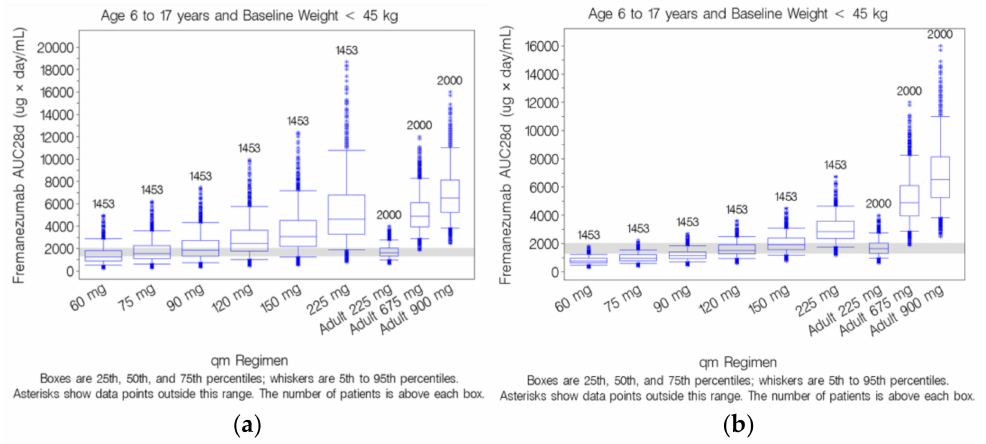
Figure 3. Simulated steady state fremanezumab AUC 28d for pediatric patients 6 to 17 years of age with baseline body weight <45 kg compared to the adult distribution following fremanezumab 225 mg subcutaneous monthly administration based on different revisions to the pediatric population pharmacokinetic model: ( a ) fixed allometric exponents 1 , ( b ) bioavailability and lag time fixed to adult values 1 . AUC 28d : area under the concentration time curve from time 0 to 28 days, qm: monthly. 1 Subfigures a and b were reproduced with permission from [29], SAGE Publications,